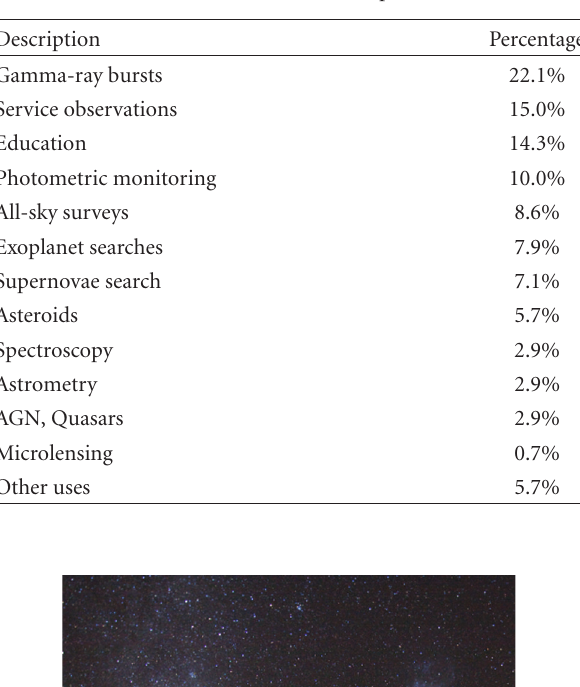
Table 1: Scientific use of RAOs (adapted from [46]).